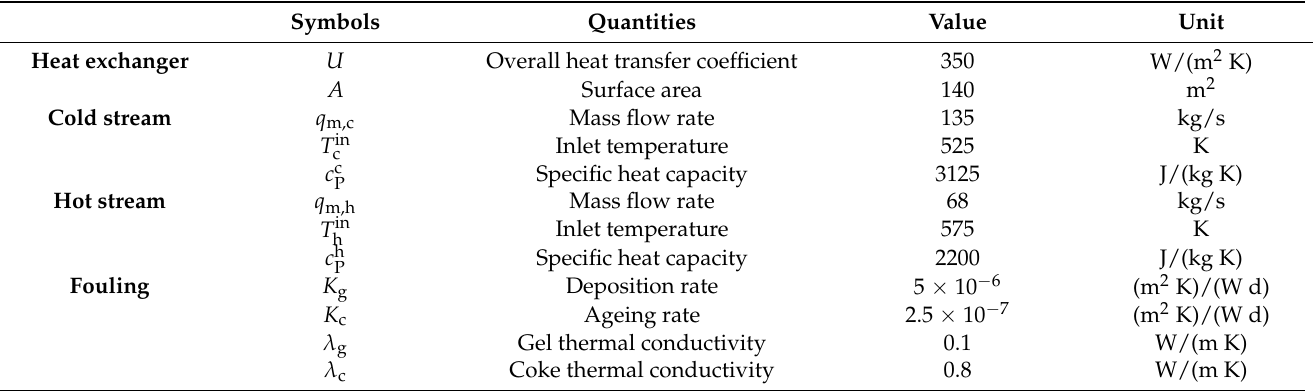
Table 2. Process